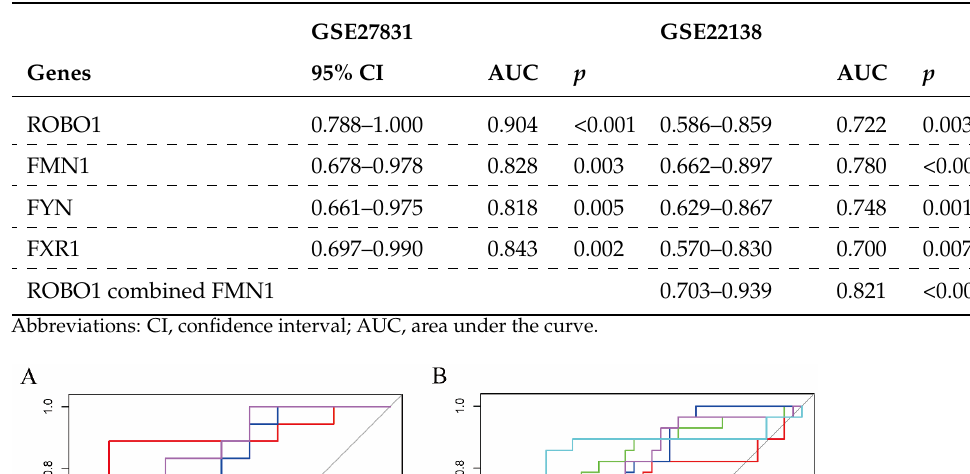
Table 3. Individual area under the receiver-operating characteristic curve (AUC) and p values of hub genes to predict metastasis.